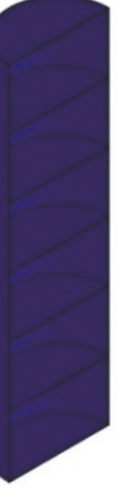
Figure 3: The structure of drag rotor.